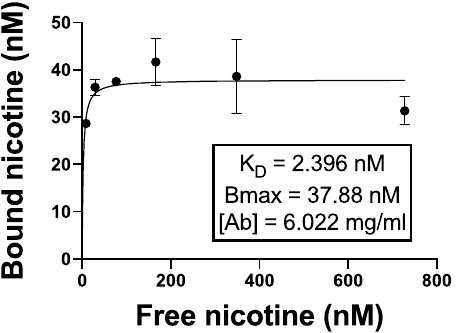
Fig 1. Measurement of ATI-1013 affinity for S-Nicotine. Affinity was measured by equilibrium dialysis at 25˚C using 3 H-nicotine. Duplicate samples of ATI-1013 were diluted to 2.8 μ g/mL and plated to one side of 96-well equilibrium dialysis plates. The dialysate side consisted of a range of nicotine concentrations (8–256 ng/mL) mixed with approximately 10 4 DPM/0.1 mL radiolabeled nicotine. Plates were placed on a shaker for 72 h at room temperature. The radiolabeled nicotine was used to measure nicotine concentrations on both sides of the membrane. K D and B max were measured using One-site–Specific Binding in Prism 8.0 (GraphPad Software Inc., La Jolla CA). Data are represented as mean ± SD.